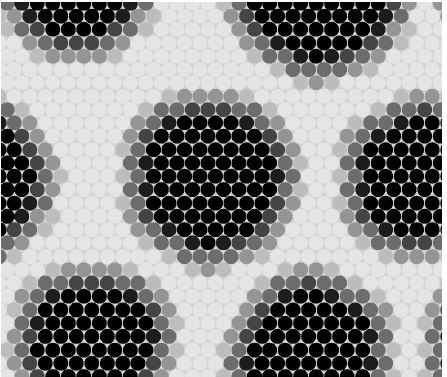
Figure 10: The internal structure of a model metal-ceramic composite with a "wide" transition zone (~0.8  m in the present example) between TiC particles (shown in black) and the Ni-Cr binder (shown in light gray). Shades of gray color of varying intensity mark areas of the transition zone with appropriate content of